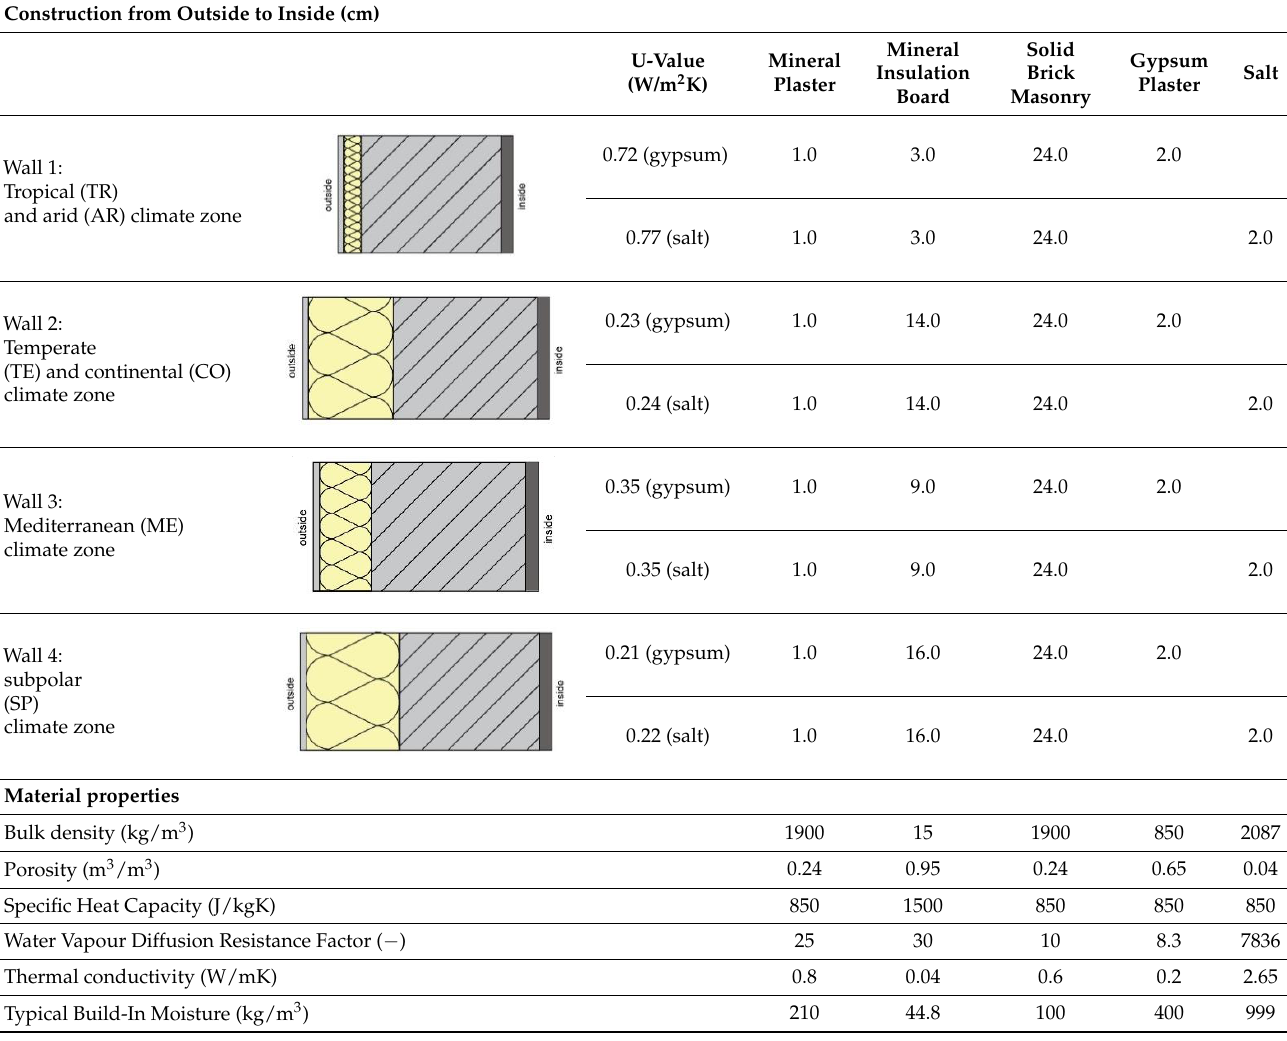
Table 3. Boundary condition (construction of the exterior walls with the material properties). The indoor material layer is gypsum or salt (dark grey).